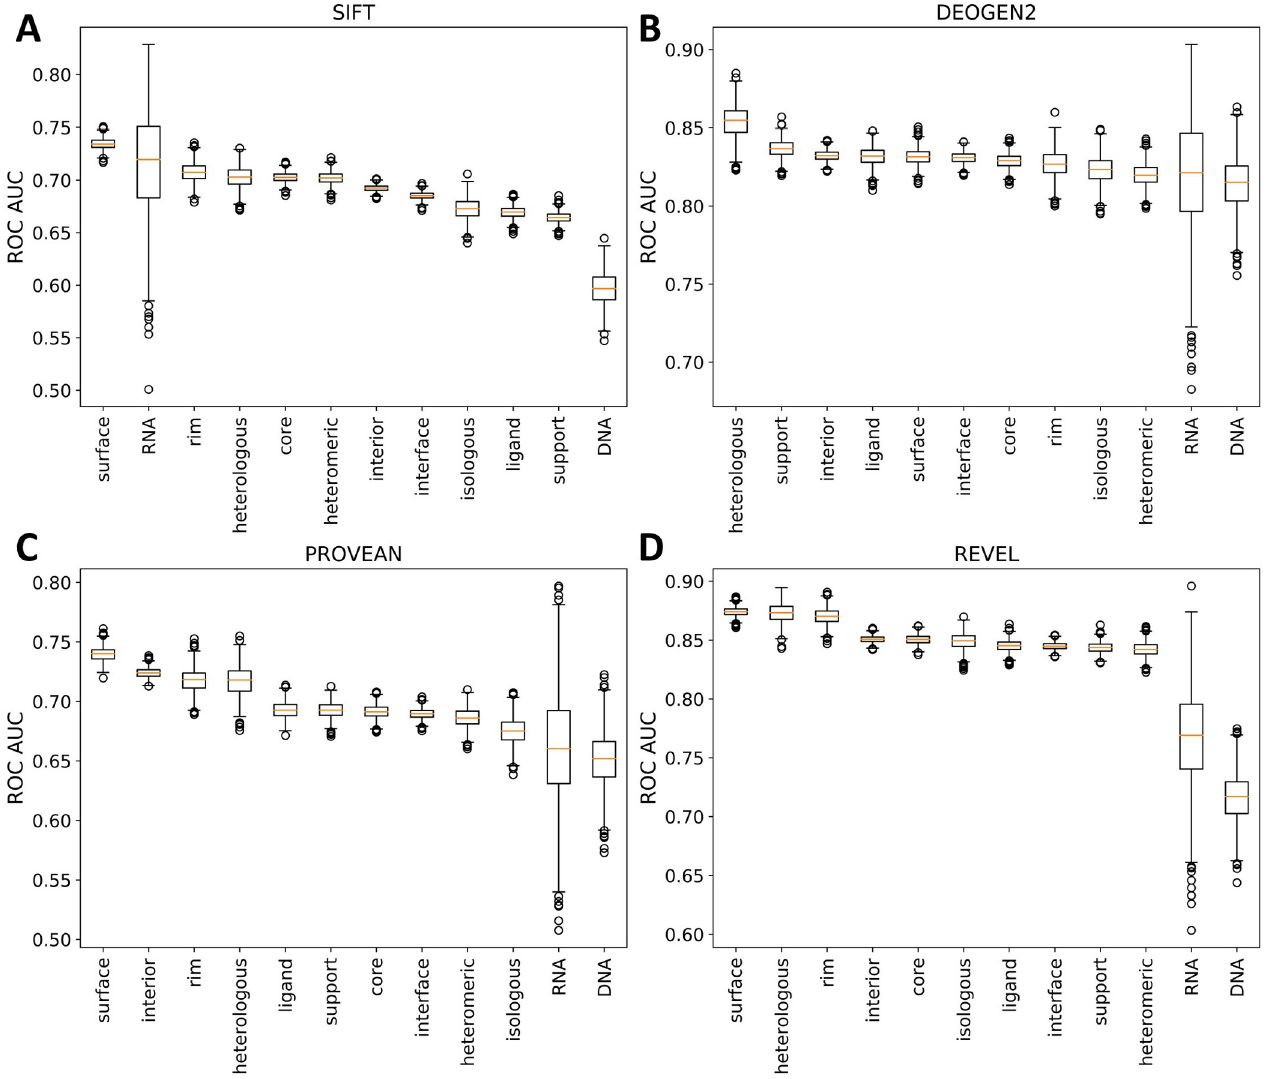
Fig 7. Distribution of bootstrapped ROC AUC for predictions made by four representative variant effect predictors at different protein locations. A) SIFT: an empirical predictor. B) DEOGEN2: a supervised machine learning method. C) PROVEAN: an unsupervised machine learning method. D) REVEL: a metapredictor ( i . e . ensemble predictor). Charts for all predictors are available in Fig K in S1